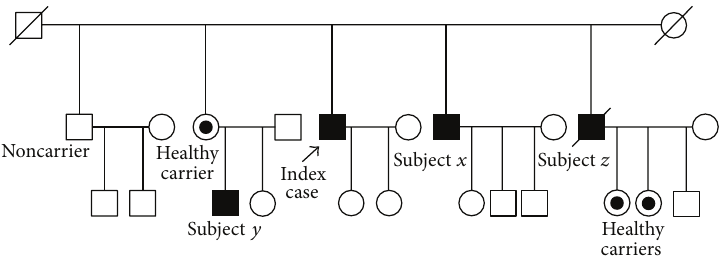
Figure 1: Family tree. Subjects 𝑥 and 𝑦 are affected carriers. Subject 𝑧 has two carrier daughters and is suspected to have been an affected